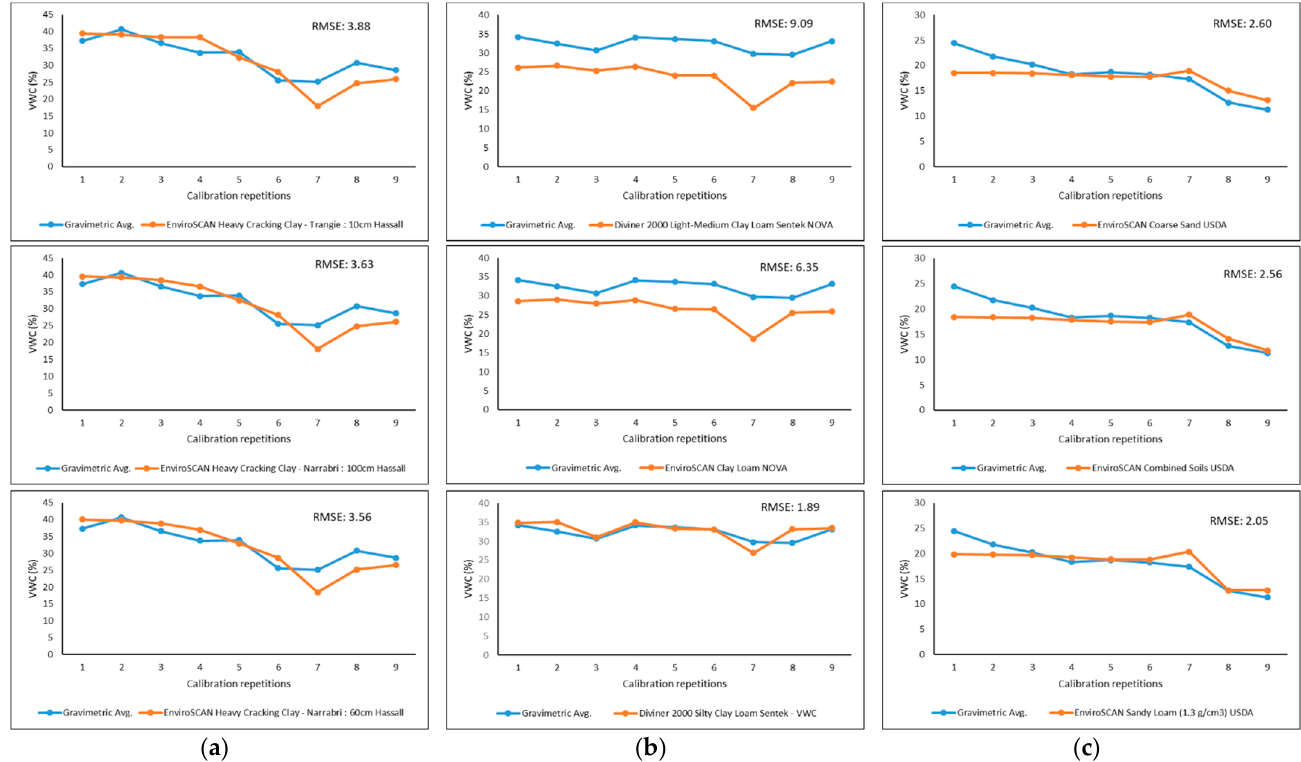
Figure 6. Gravimetric VWC (blue line) compared with the three best fit soil-specific EnviroScan calibration equations (orange lines) indicating the corresponding texture class: ( a ) clay; ( b ) loam; ( c ) sand.